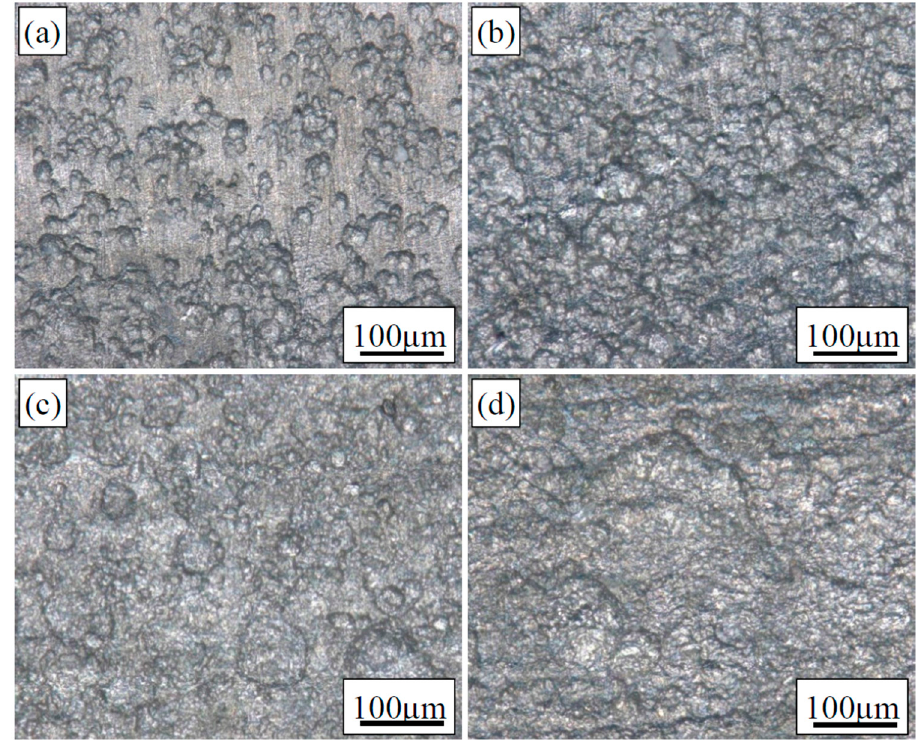
Figure 5. Corrosion morphology of L80 steel after immersed in the medium of 80 wt % water content for under preloading stresses of: ( a ) 0 σ s ; ( b ) 0.5 σ s ; ( c ) 0.8 σ s ; and ( d ) 1.0 σ s .